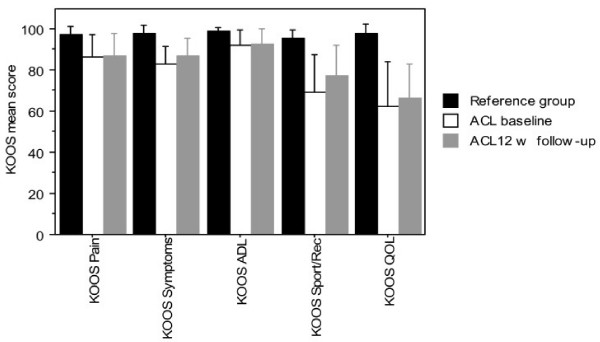
Mean (95% CI) KOOS scores for the reference group and the ACL group before and after the 12 week training programme.